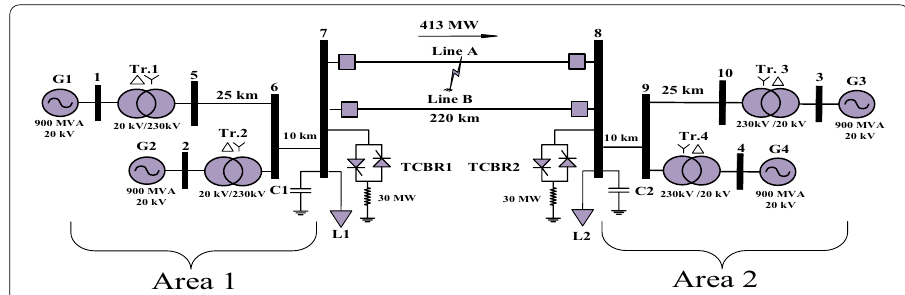
Fig. 1 Single‑line diagram of four‑machine two‑area test power system with dual 30 MW